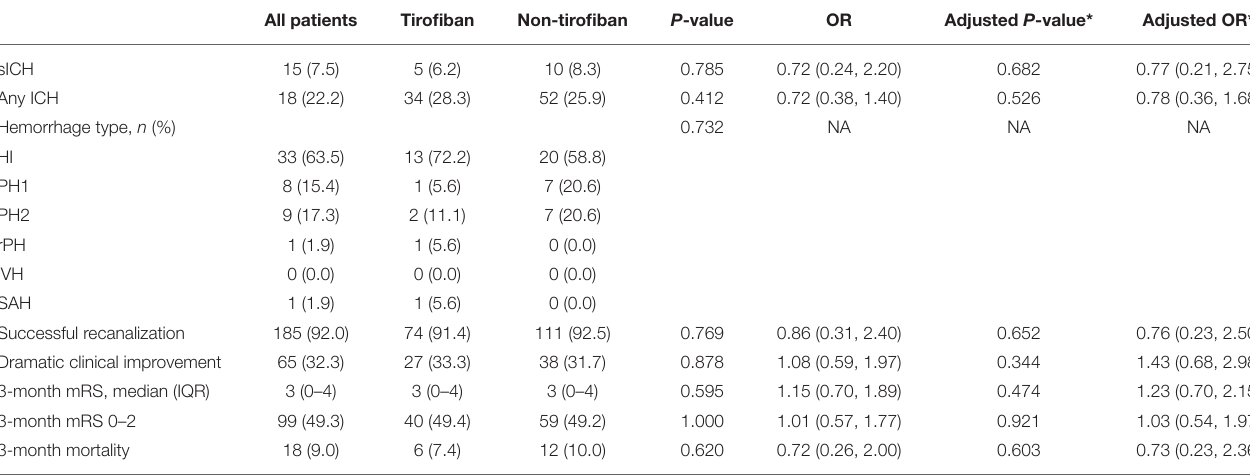
TABLE 3 | Safety and efficacy endpoints of MT patients with preceding intravenous thrombolysis before PSM. All patients Tirofiban Non-tirofiban P -value OR